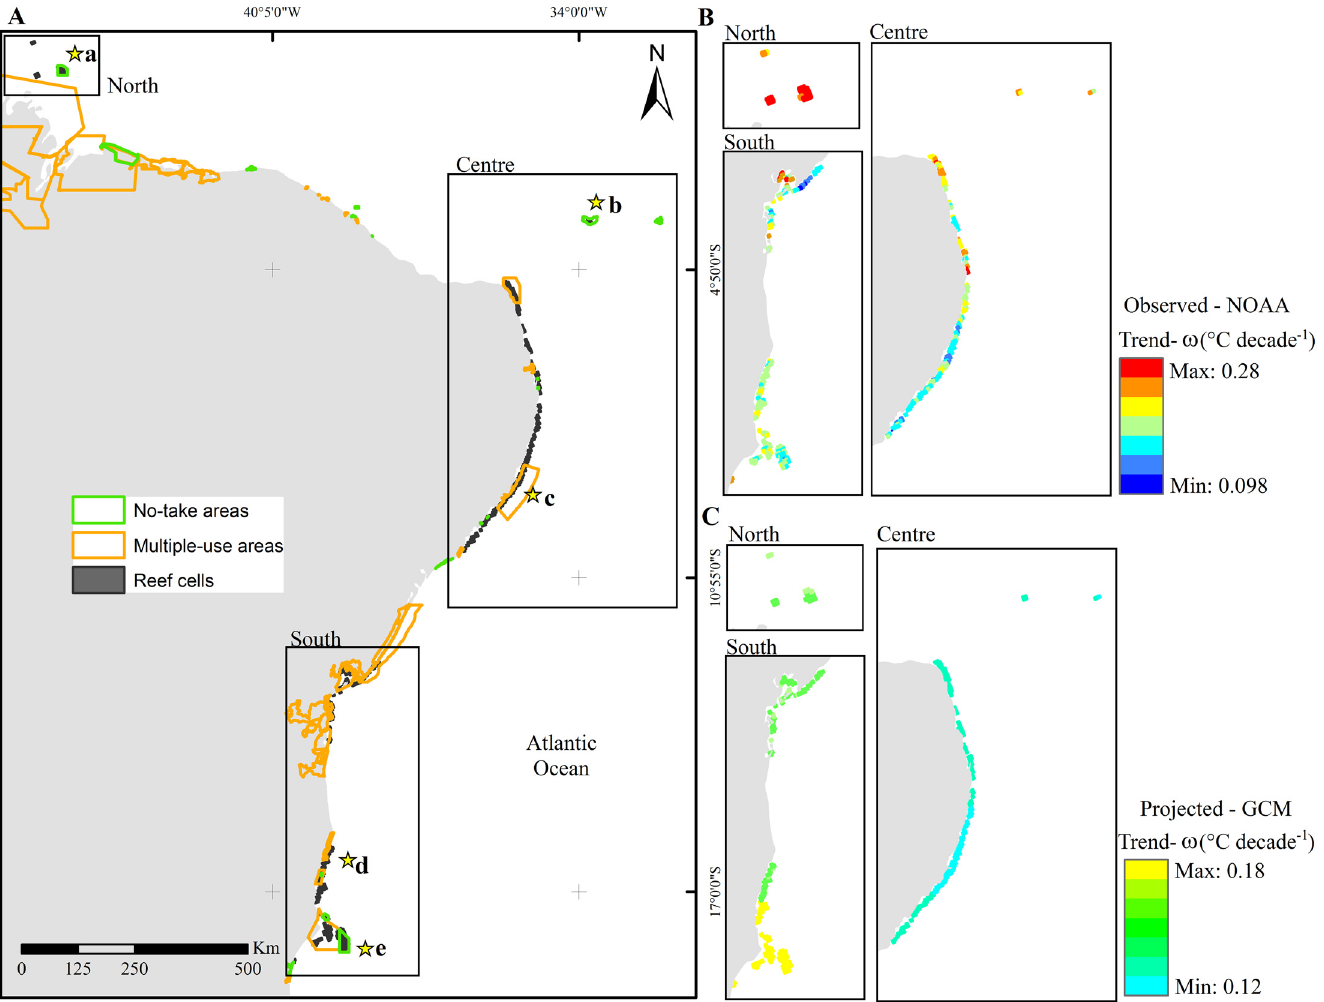
Fig 2. The study area and the chronic stress metric. (A) Sectors (northern, central, southern), reef cells (n = 428), and the existing MPA boundaries along the Brazilian coast. MPAs are classified according to their main management categories: no-take areas and multiple-use areas. Letters a-e with stars denote approximate locations of reef cells selected to depict temperature variability (see Fig 6). (B) Decadal SST trends describe observed chronic stress for each reef cell from NOAA satellite data. (C) Decadal SST trends describe projected chronic stress for each reef cell, downscaled from PCM1 general circulation model